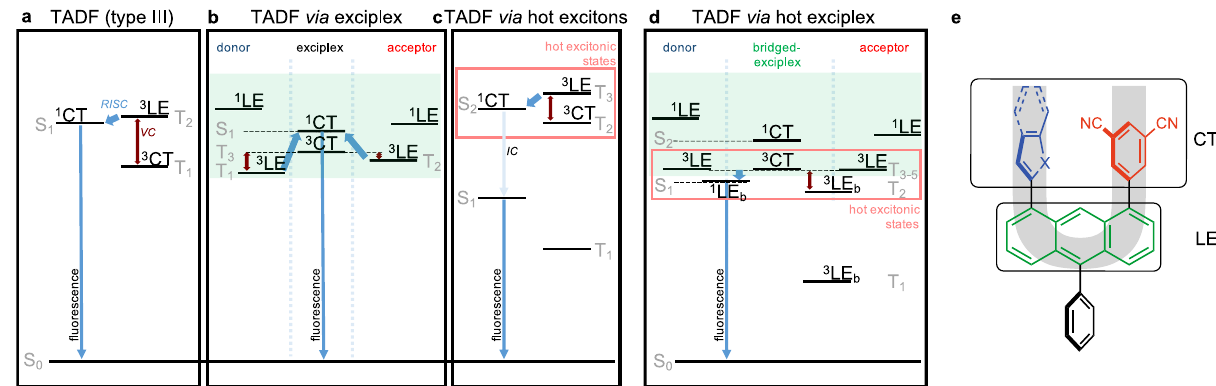
Fig. 1 Design considerations for hot exciplex TADF emitters. a Type III TADF, where T 1 and T 2 are vibronically coupled (VC, dark red arrows) and RISC (bent blue arrows) occurs from T 2 to S 1 , which is a CT. b In an exciplex, two charge transfer states are generated, the 3 CT is vibronically coupled to locally excited triplet states on the donor and acceptor moieties and after RISC, emission occurs from the charge transfer singlet state 1 CT. c In hot exciton TADF emitters, there is a large energy gap between T 1 and T 2 rendering the T 2 stable, so that VC and RISC takes place between the hot triplet states and a singlet state. If that singlet is an upper excited state, internal conversion (IC) to the S 1 can take place. Molecular design can render this state a locally excited state. d By bridging donor and acceptor with anthracene, a mixture of the exciplex and hot exciton mechanisms can be produced. Here, hot excitonic states are produced with participation by the exciplex states. As a result, the S 1 is always a 1 LE state, which is bene fi cial for high-ef fi ciency emitters. The subscript b indicates that this state is localized on the anthracene bridge. e U-shaped hot exciton design, containing an anthracene unit (green) which holds the LE and bridges the donors (blue; X = O, S) and acceptor (red) moieties. The acceptor unit in all cases is isophtalonitrile; employed donor units are methylfuran, benzofuran, methylthiophene, and benzothiophene. The phenyl ring (black) improves